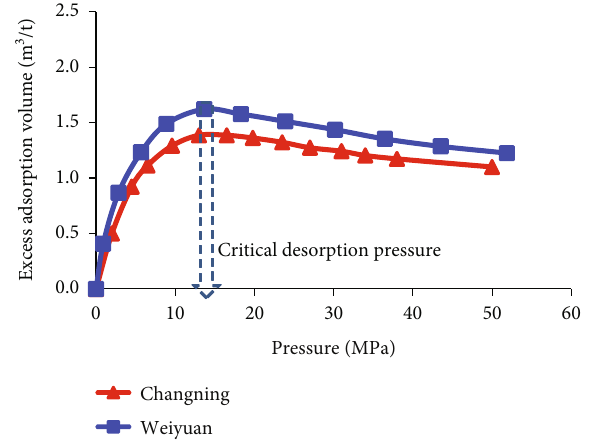
Figure 10: Critical desorption pressure in adsorption isotherm